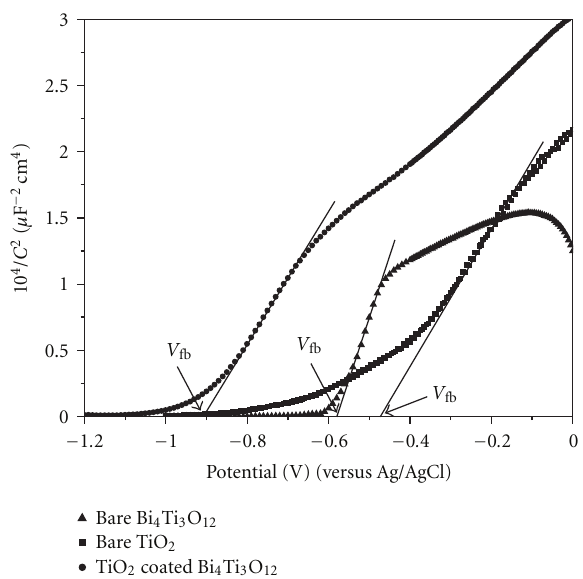
Figure 7: Mott-Schottky plots of bare (curve a) and 5 at % TiO 2 - modified Bi 4 Ti 3 O 12 (curve b) thin films, V fb , the flat band